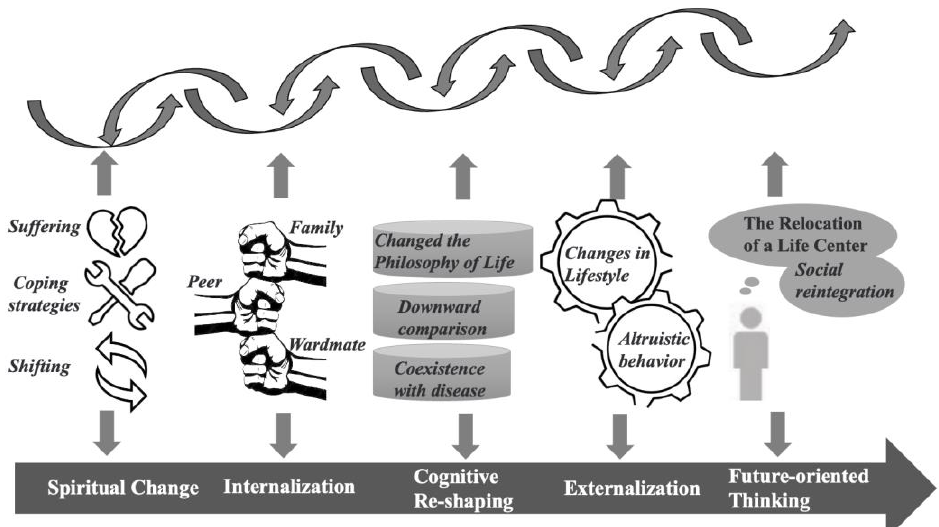
Figure 1. The conceptual model of the generation of post-traumatic growth.